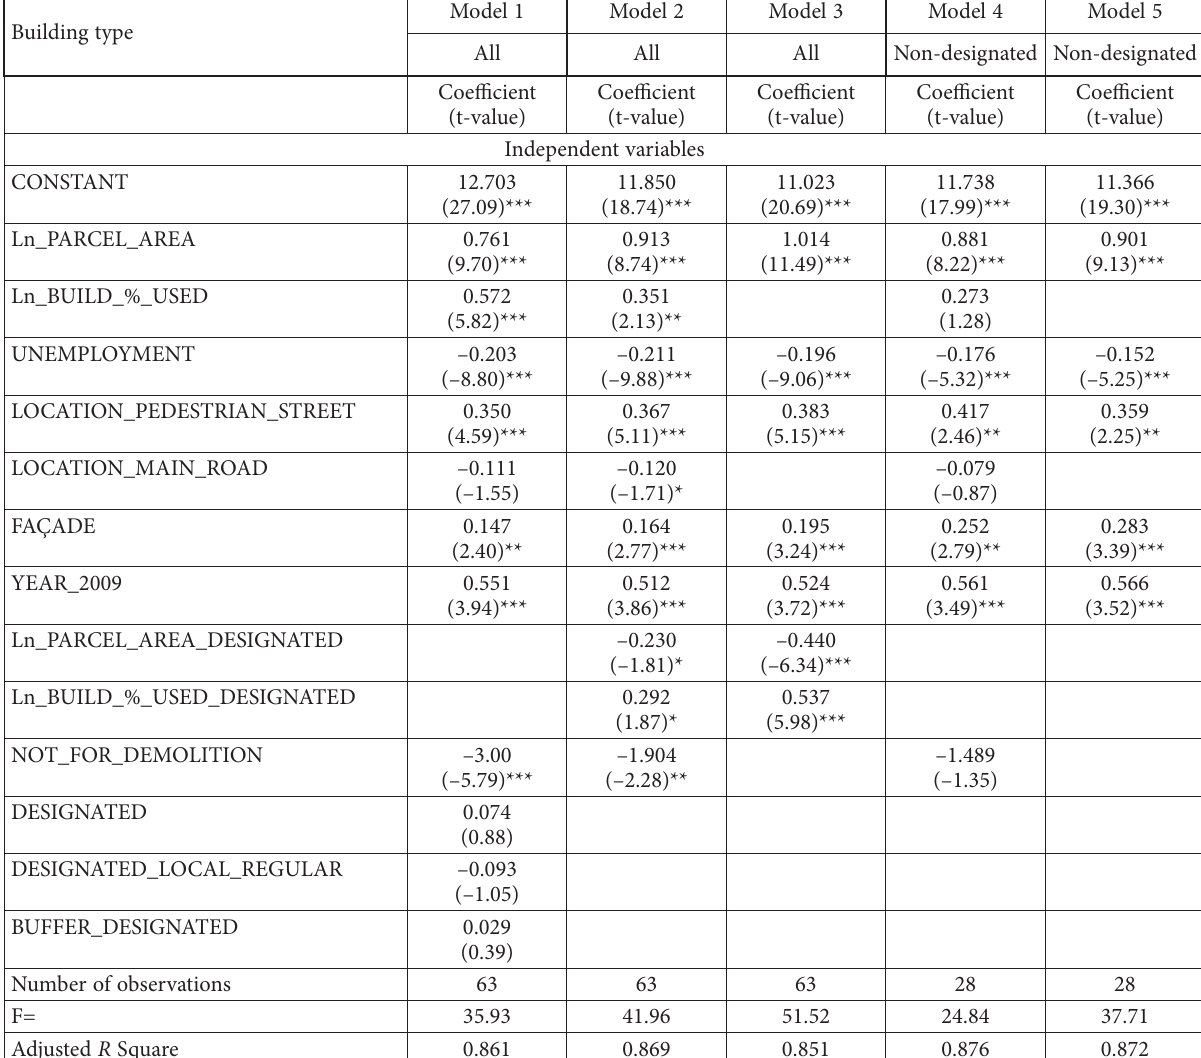
Table 3. Estimated coefficients for building